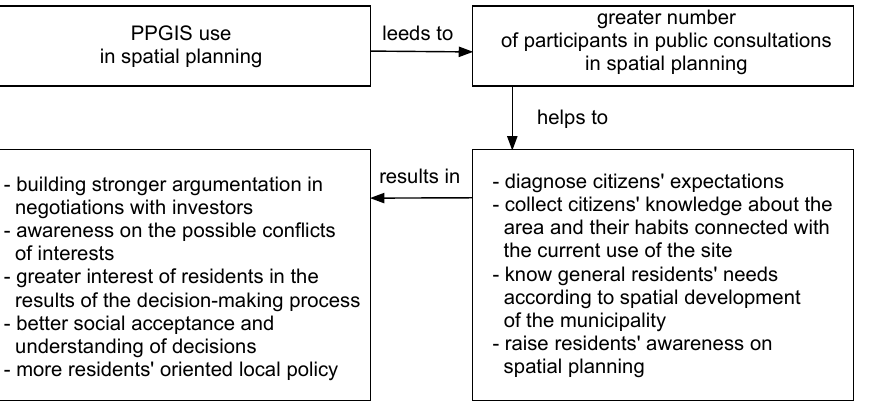
Figure 8. The role of PPGIS in decision making in local governance. Source: own elaboration.